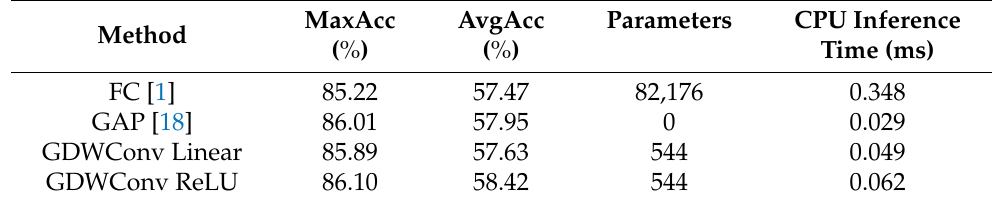
Table 8. Performance comparison with different feature reconstruction methods on RadioML2016.10A dataset.